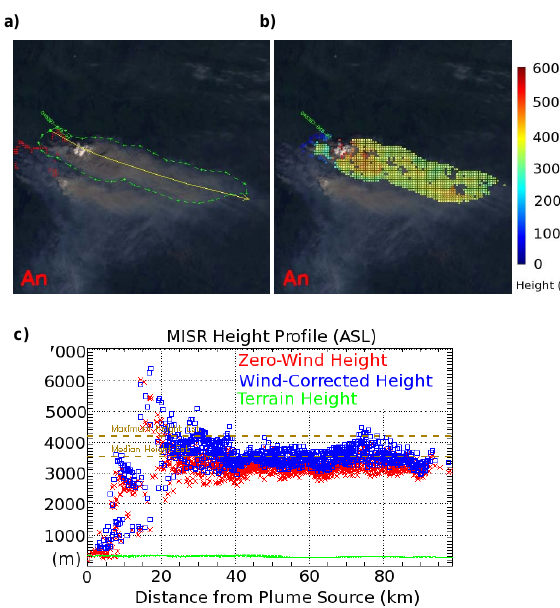
Fig. 2. Example of plume digitization produced by the MINX software package for a Canadian plume on 30 June 2008. Panel a) shows a smoke cloud (outlined in green) with associated MODIS fire pixels (red dots). Panel b) depicts the same plume with a stereo height overlay. The label "An" in panels (a) and (b) indicates that these are nadir images. Panel c) shows individual stereo-heights within the plume in relation to their distance from the source. Planar maximum and median plume heights are shown as dashed lines. MINX images courtesy the MISR Plume Height Climatology Project. (http://www-misr2.jpl.nasa.gov/EPA-Plumes/)